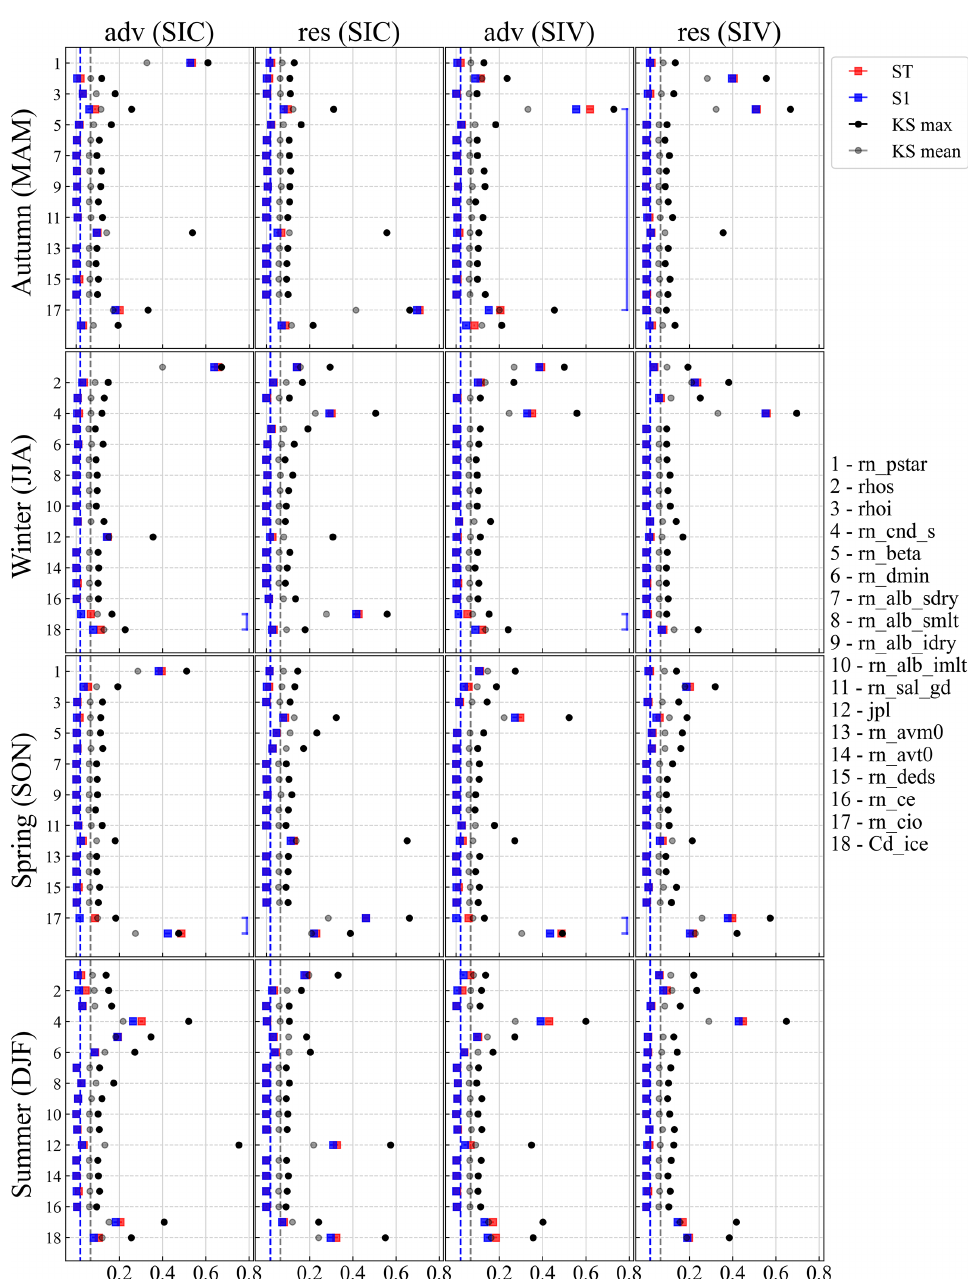
Figure 8. The total (ST) and first-order (S1) Sobol sensitivity indices and the maximum (KS max) and mean (KS mean) PAWN sensitivity indices for each sea ice budget component of 18 parameters. The dashed blue and grey lines are the thresholds for S1 and KS mean indices, respectively. Larger Sobol and PAWN index values indicate that the metric is more sensitive to this parameter. The blue connecting line indicates that the Sobol second-order index for the combination of these two parameters is greater than